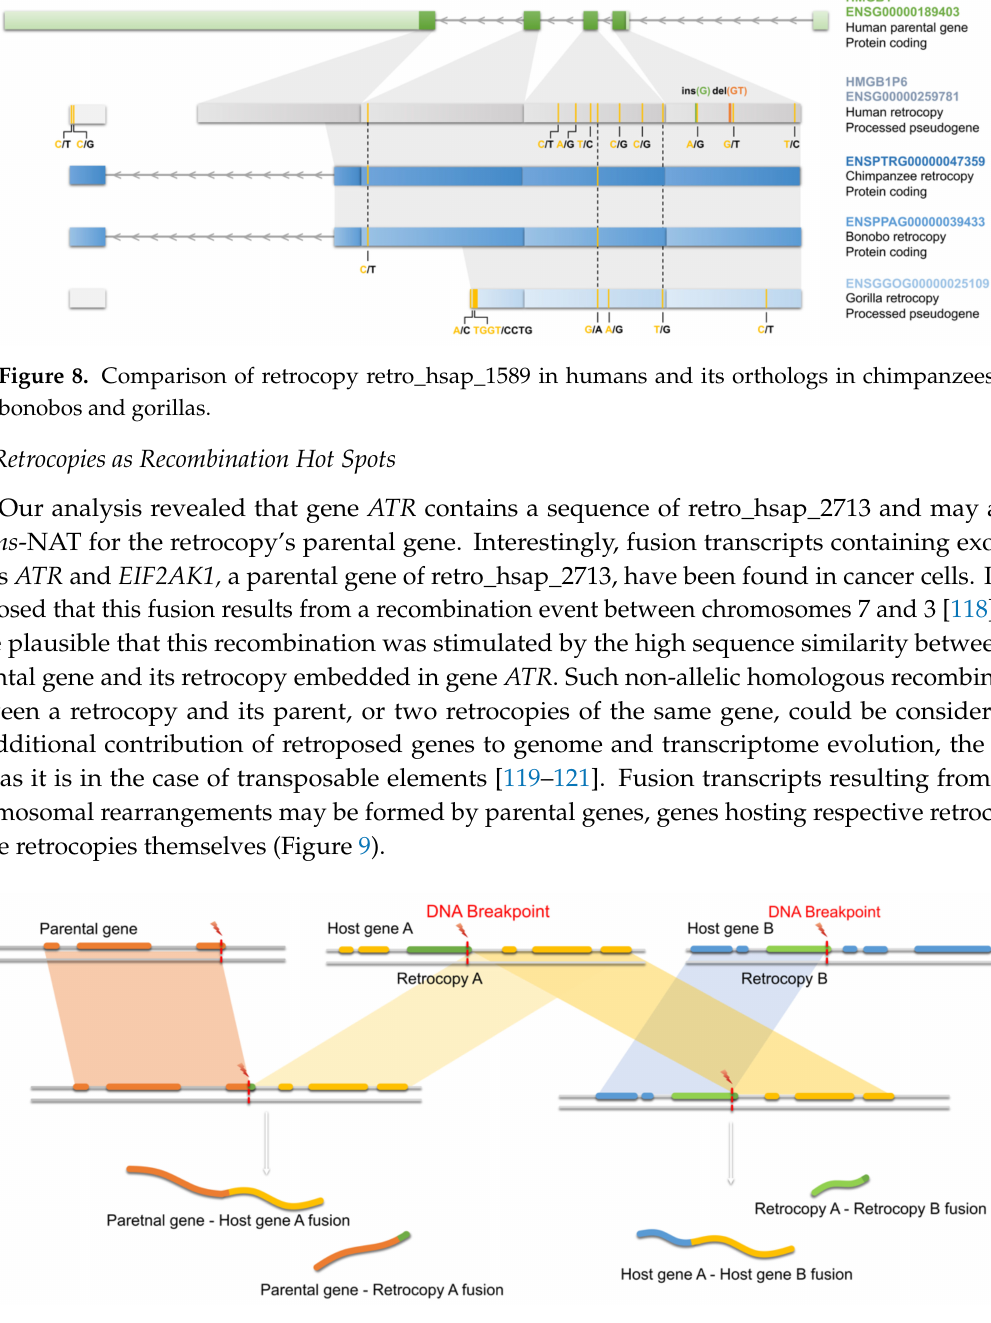
Figure 9. Possible outcomes of recombination events with the involvement of